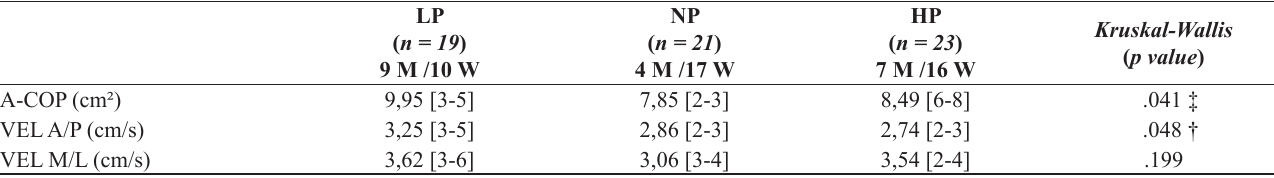
Table 2. Comparison of postural control between groups.